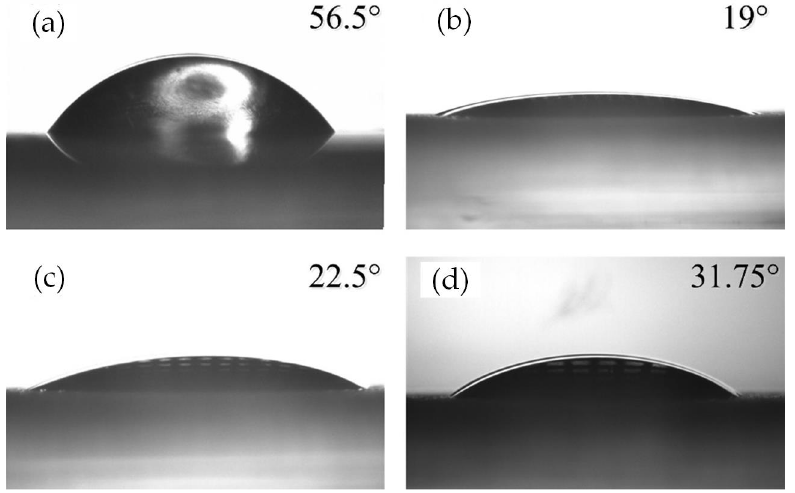
Figure 2. 2D profiles for different types of untreated or laser-treated surface: ( a ) smooth surface; ( b )